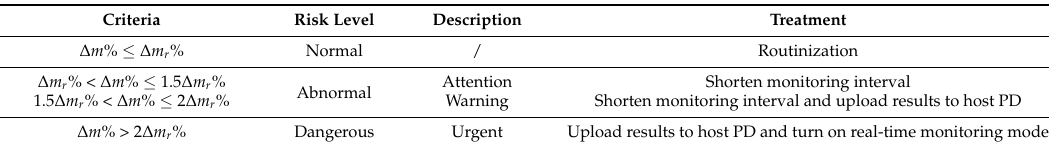
Table 4. Risk determination via parallel